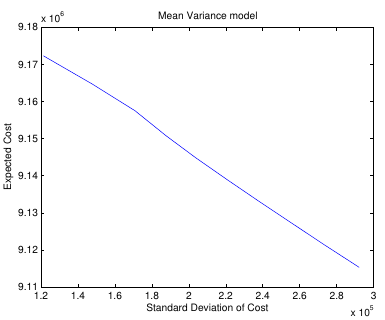
Figure 8. Efficient frontier of mean variance model.